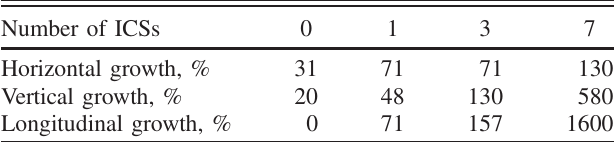
TABLE III. Rms-emittance growth with several ICSs and k